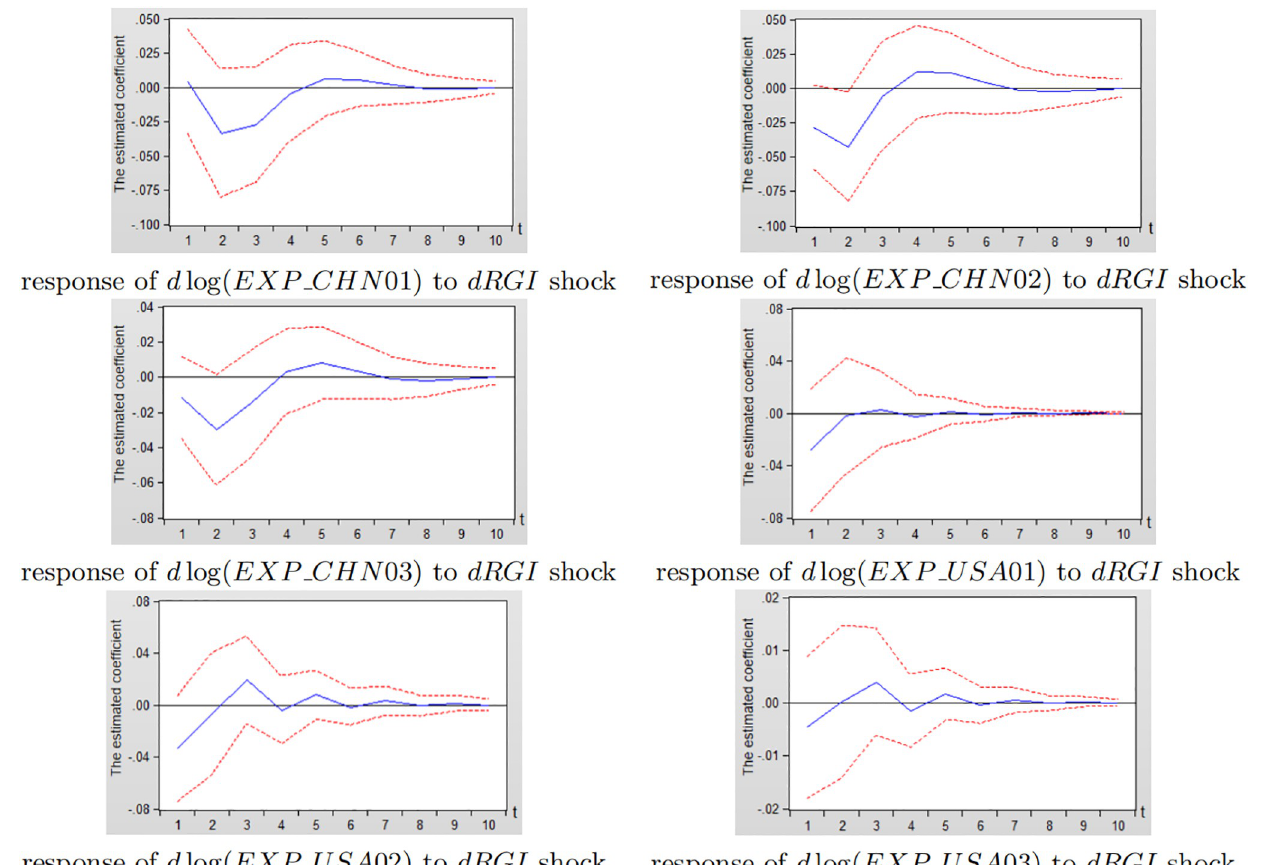
Fig 9. Impulse response diagrams of reverse globalization to the exports of three major industries between China and the United States.